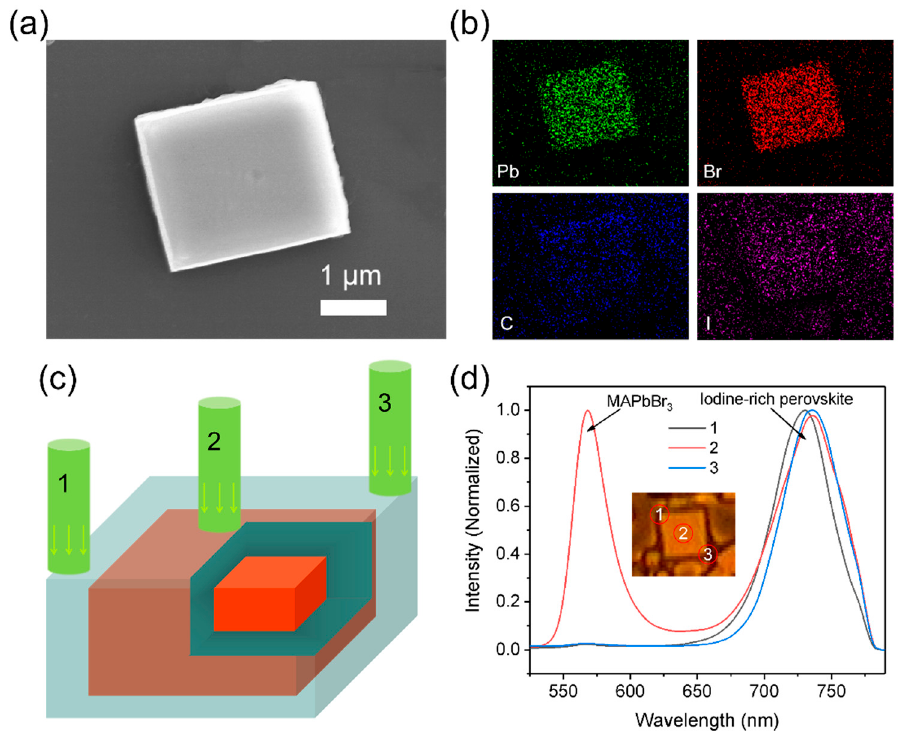
Figure 5. ( a ) Top-view SEM images of the perovskite with PEAI (0.15 mol/L). ( b ) Elemental mapping images corresponding to the SEM image. ( c ) Schematic diagram of perovskite grain excited by 532 nm laser. ( d ) PL spectral of perovskite grain with PEAI (0.15 mol/L) at different positions.